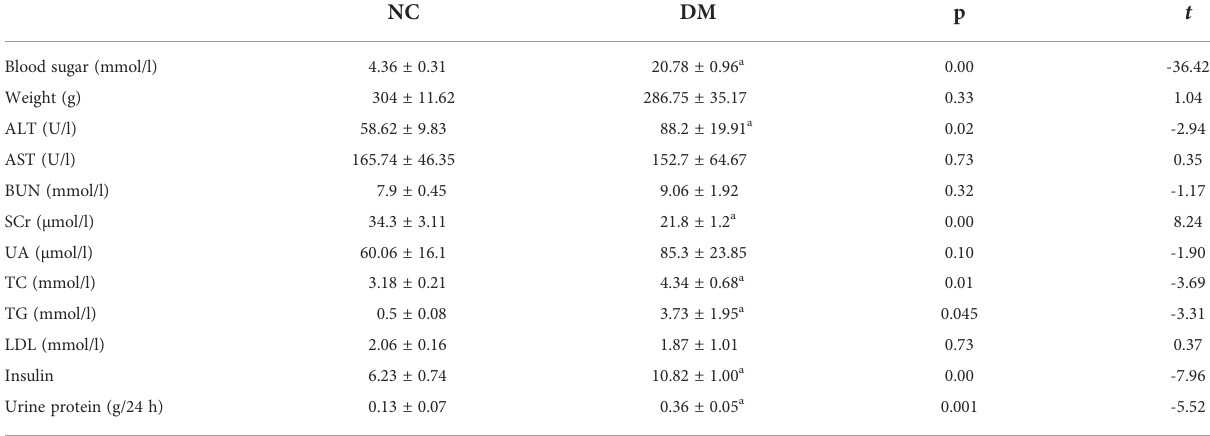
Comparison of general, blood, and urine biochemical data between the two groups of ZDF